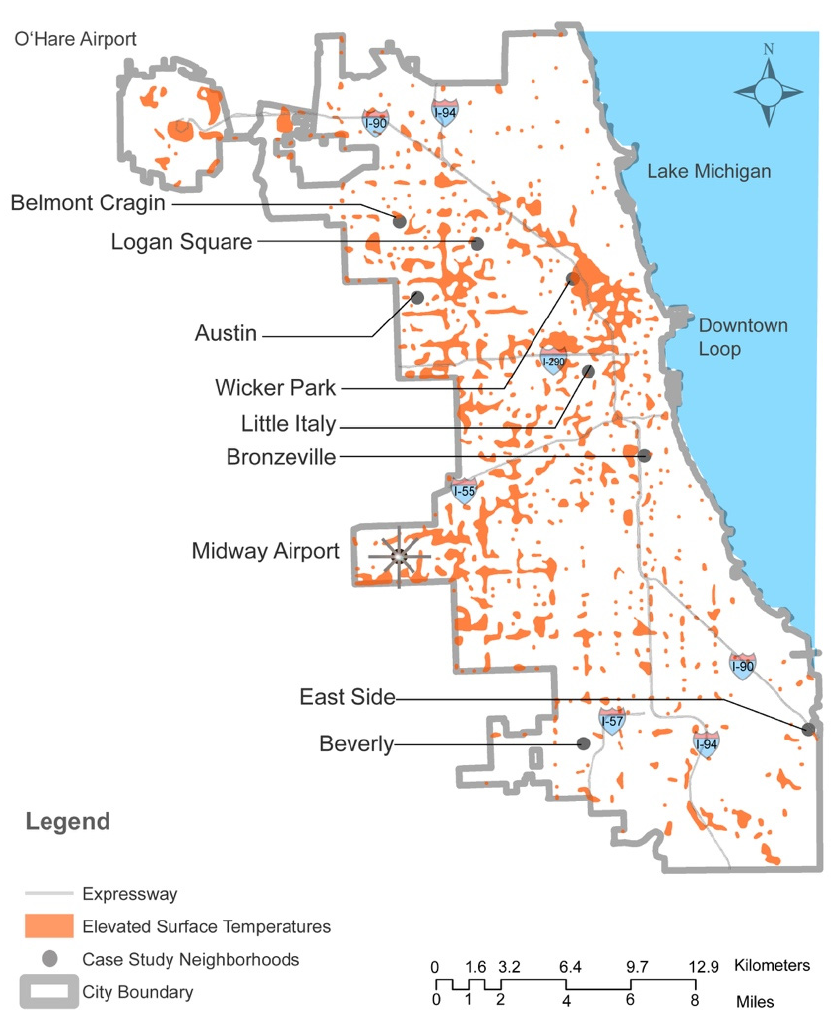
Figure 2. Map illustrating the city of Chicago limits, the eight study neighborhoods, Midway Airport, and the heterogeneous distribution of elevated surface temperatures from a City of Chicago Department of the Environment 2006 study. Data source: City of Chicago Department of Environment GIS database, accessed February 1, 2010 [57] Illustration: by authors and modified from Coseo & Larsen [4].